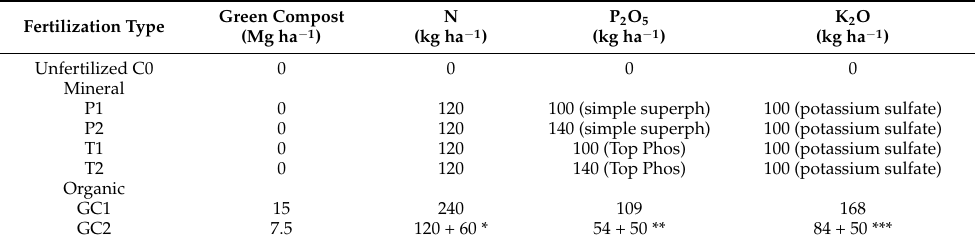
Table 1. Fertilization conditions applied to wheat durum ( Triticum durum Desf.) cv Anco Marzio and